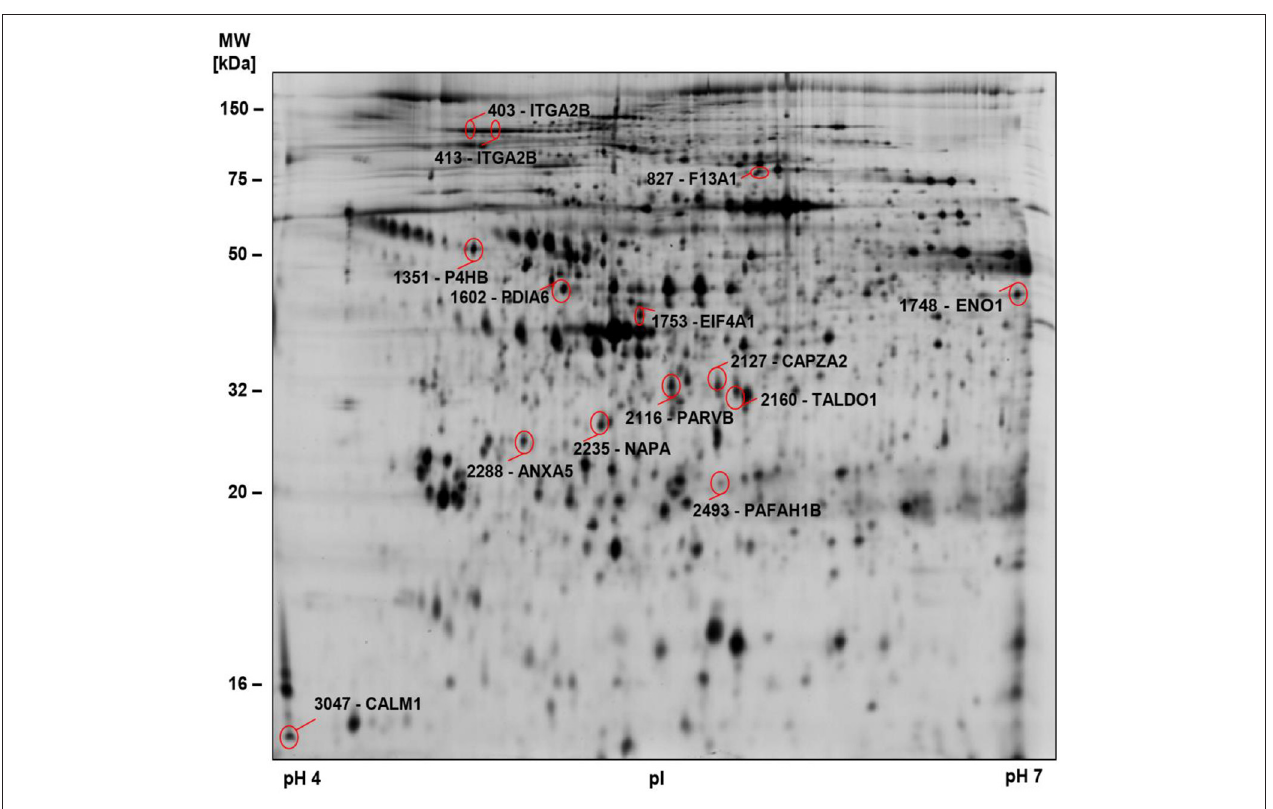
FIGURE 2 | 2D-DIGE-based proteome analysis of platelets from COVID-19 patients compared to controls. Representative 2D-DIGE image of protein spots with significant alterations in COVID-19 patients compared to controls (see Table 3 ). Platelet protein extracts were separated according to the isoelectric point (pI) in the pH 4–7 range and the molecular weight (MW). Protein spots identified by MS are circled and labeled with their corresponding gene name and spot numbers. Detailed descriptions of the highlighted proteins are listed in Table 3 .